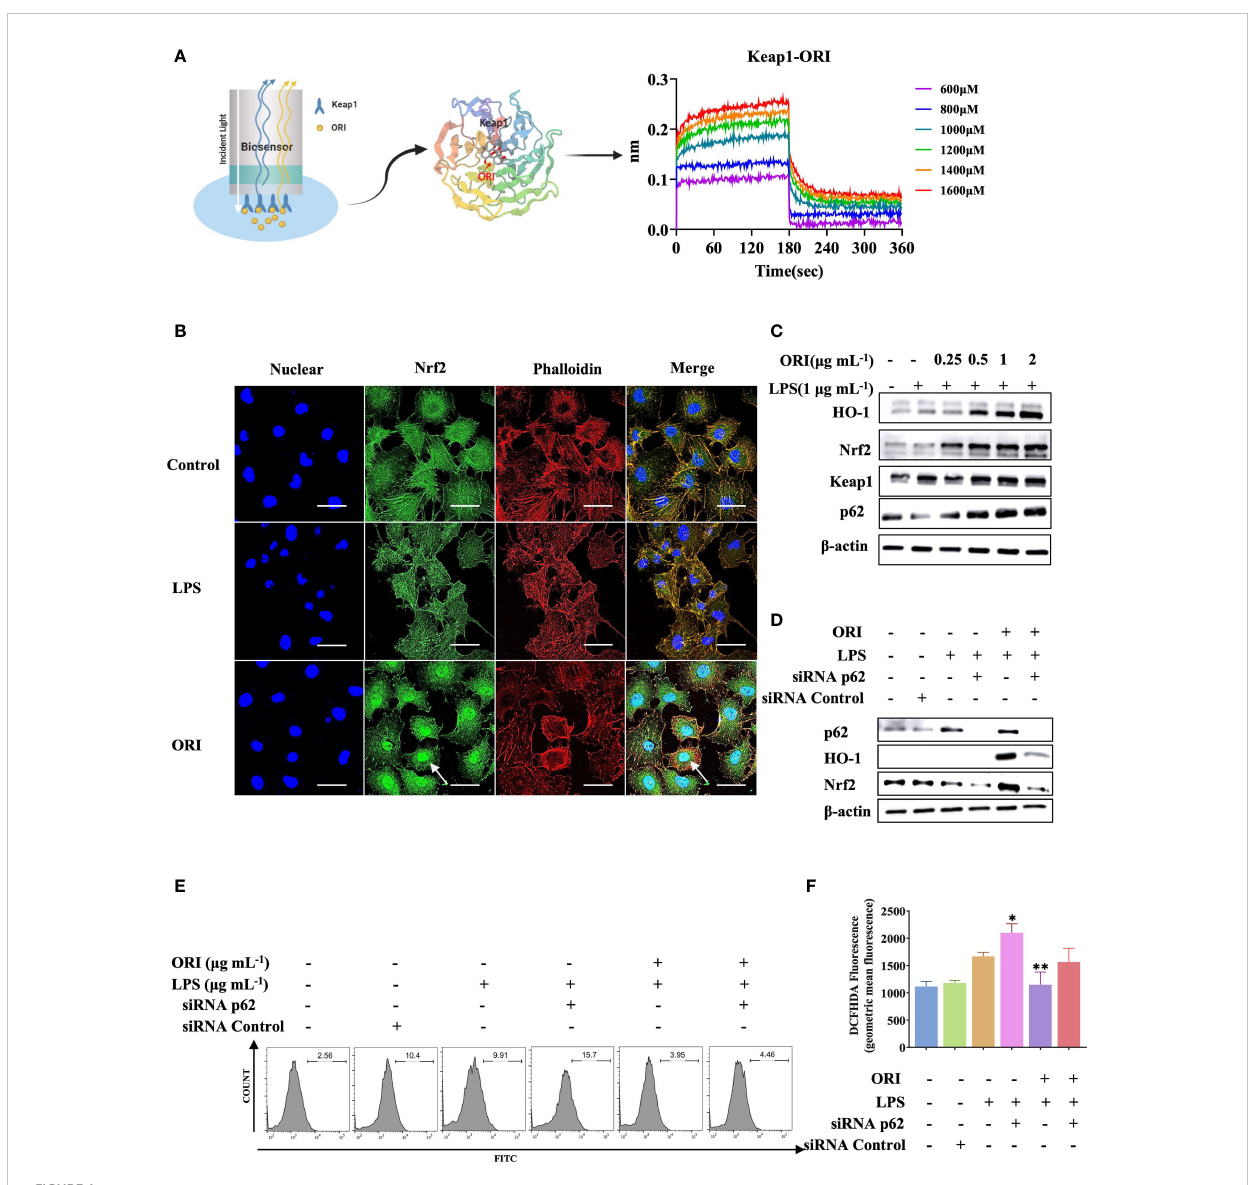
FIGURE 1 Keap1 is the molecular targets of ORI to mediate anti-in fl ammatory effect. (A) The interaction between Keap1(PDB 1U6D) and ORI was determined by binding af fi nity assay. (B) After the pretreatment with 2 m g mL -1 ORI, HUVECs were stimulated with 1 m g mL -1 LPS. Nrf2 nucleus localization was determined by immunohistochemistry. The arrow showed the Nrf2 accumulation. Bars: 50 m m. (C) After the pretreatment with ORI at indicated concentrations, HUVECs were then stimulated with 1 m g mL -1 LPS for 24 hours. Protein expression of Nrf2, Keap1, p62, HO-1 and b -actin were analyzed by Western blot analysis. (D) HUVECs were transiently transfected with p62 siRNA or control siRNA for 24 hours. After the pretreatment with 2 m g mL -1 ORI for 1 hour, the HUVECs were stimulated with 1 m g mL -1 LPS. The protein expression of Nrf2, p62, HO-1 and b -actin were analyzed by Western blot. (E, F) ROS production was measured by fl ow cytometry. Data were representative three independent experiments and expressed as mean ± S.E.M. * p< 0.05, ** p < 0.01, compared to the LPS-stimulated